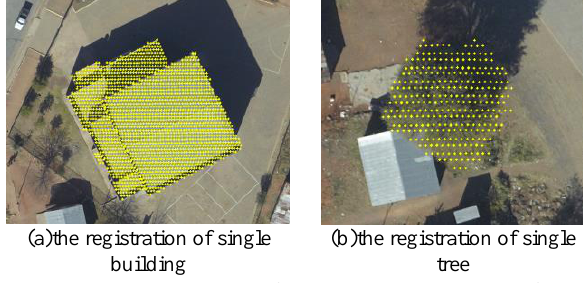
Figure 12. The registration of iamge and point cloud in African area